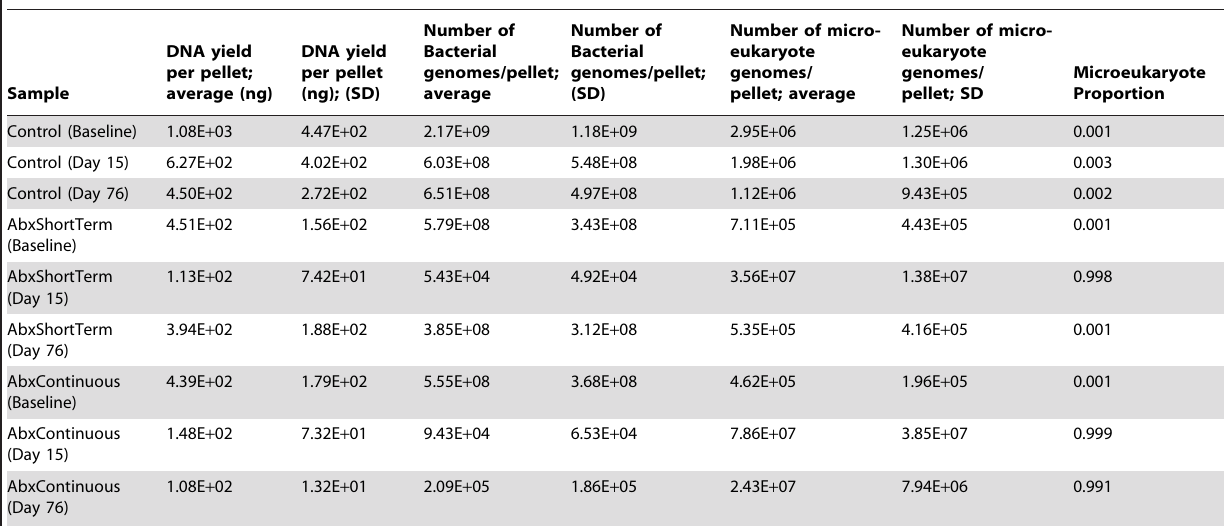
Table 1. DNA yields and numbers of genomes inferred from data on ribosomal gene copies.